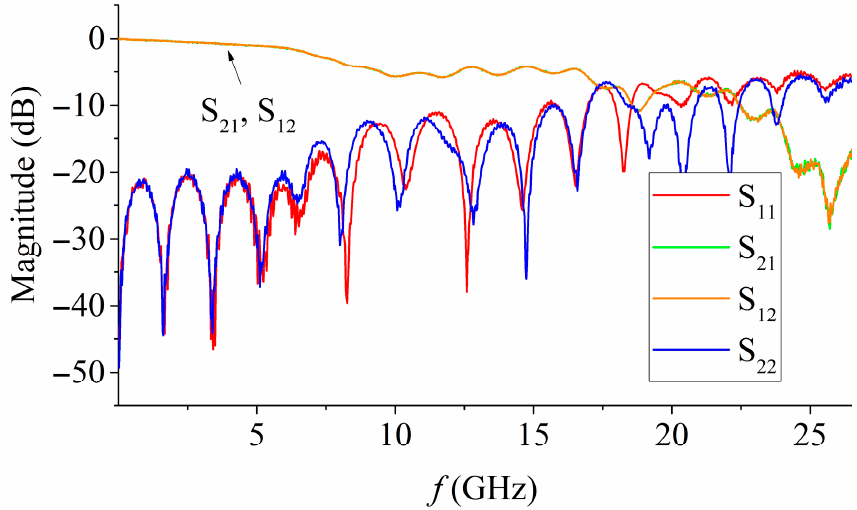
Figure 1. S parameters of MSL.